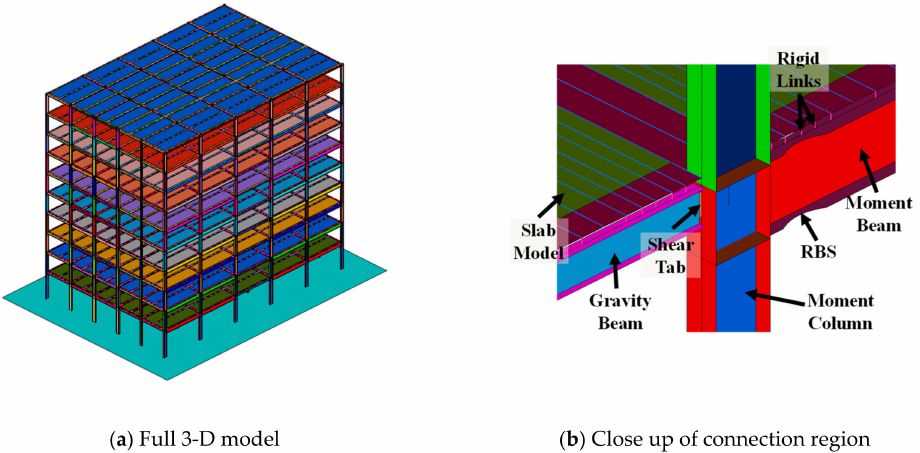
Figure 24. Details of model M1